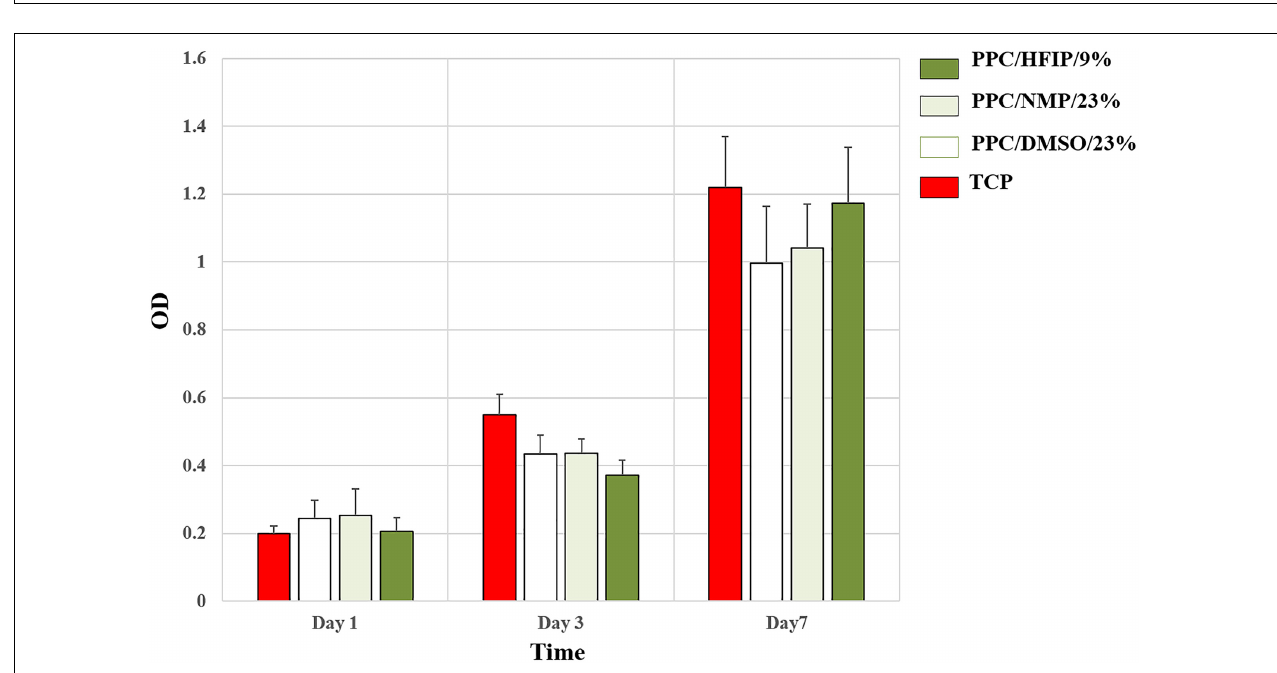
FIGURE 6 | SEM micrographs of 3T3 cells adhesion, morphology, and penetration in PES/PANI nanofibers after 48 h of culture. (A,D) PPC/HFIP/9%. (B,E) PPC/NMP/23%. (C,F) PPC/DMSO/23%.